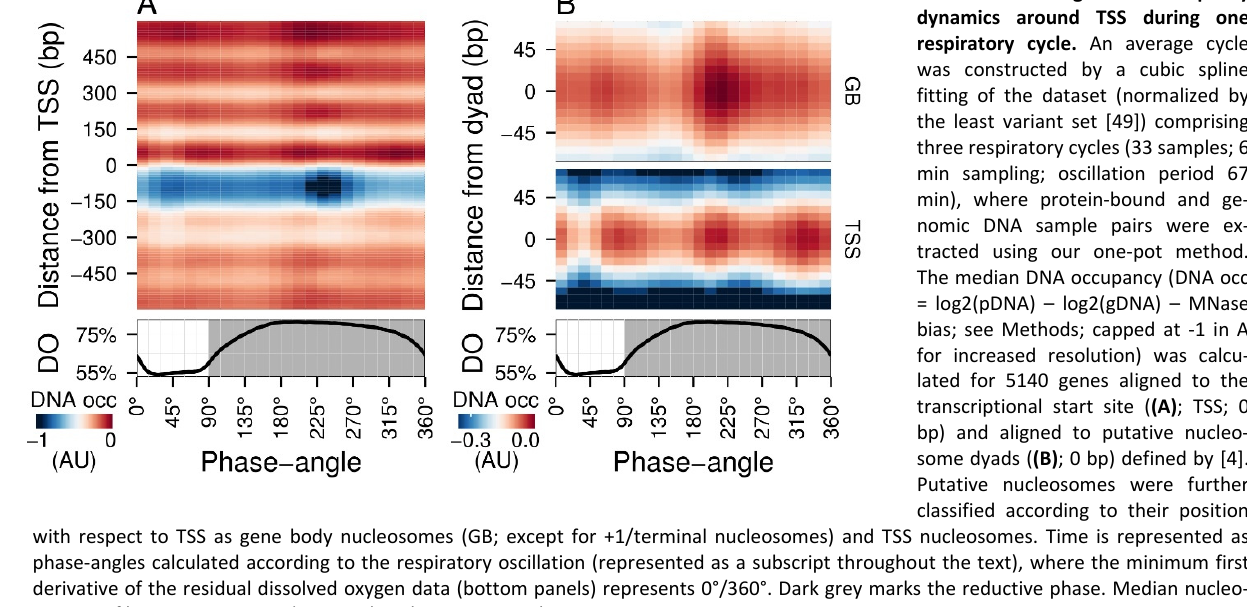
FIGURE 1: Average DNA occupancy dynamics around TSS during one respiratory cycle. An average cycle was constructed by a cubic spline fitting of the dataset (normalized by three respiratory cycles (33 samples; 6 min sampling; oscillation period 67 min), where protein-bound and ge- nomic DNA sample pairs were ex- tracted using our one-pot